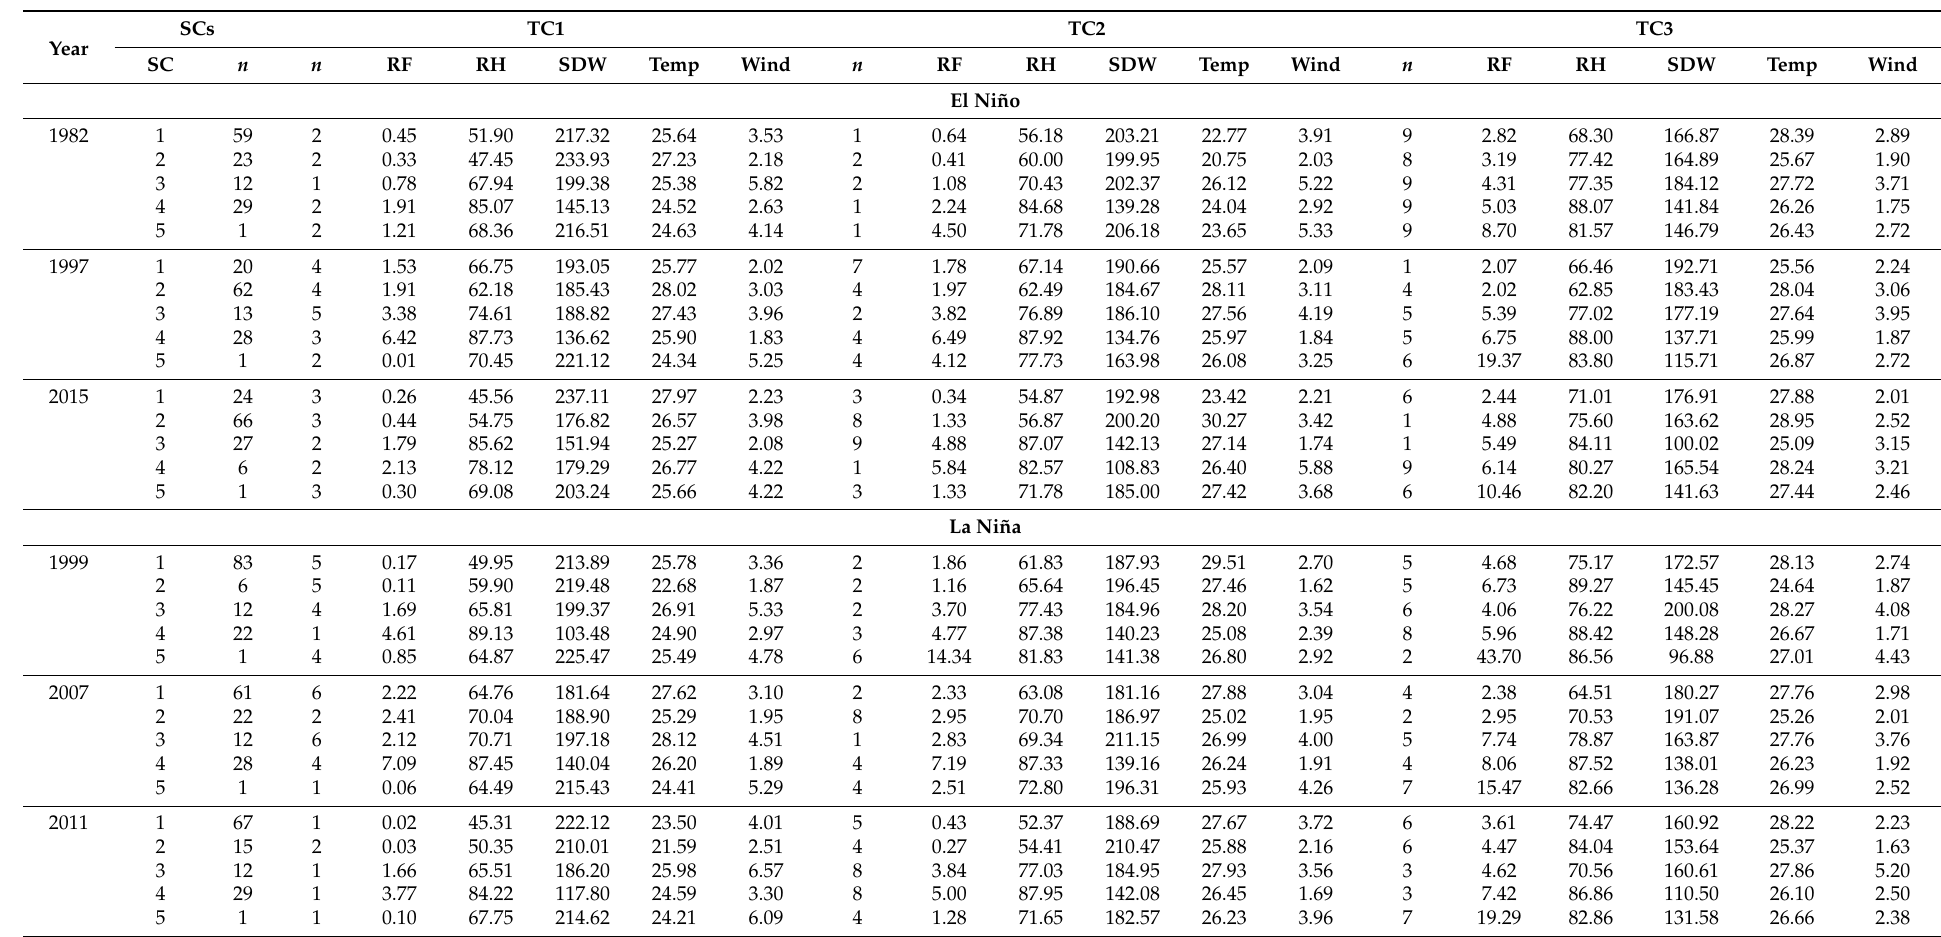
Table 5. Number of members (months) and mean of monthly climate factors by ENSO events, years, SCs and